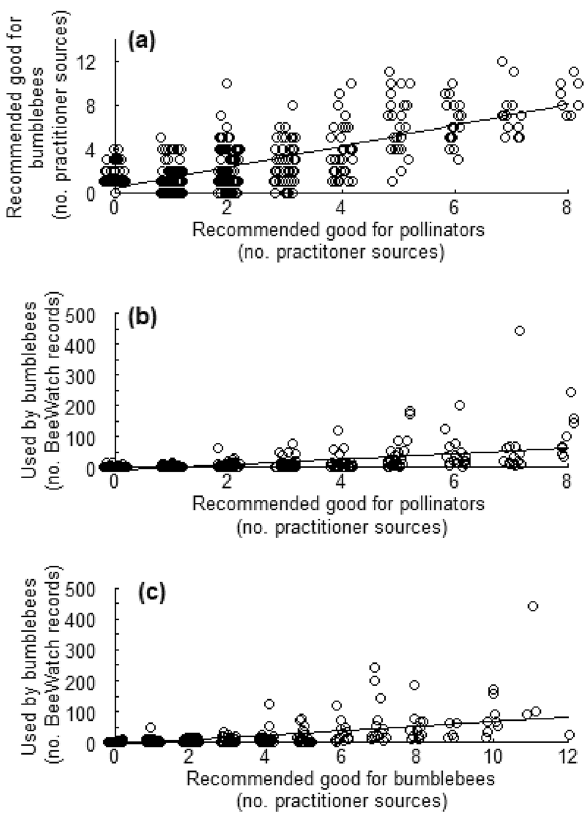
Figure 1. Relationships between the number of different sources of practitioner information recommending certain plant species as being good for pollinators in general and bumblebee specifically, and how frequently such plants have been observed being used by bumblebees based on BeeWatch citizen science data. (a) Relationship between the number of practitioner sources that recommended a plant as being good